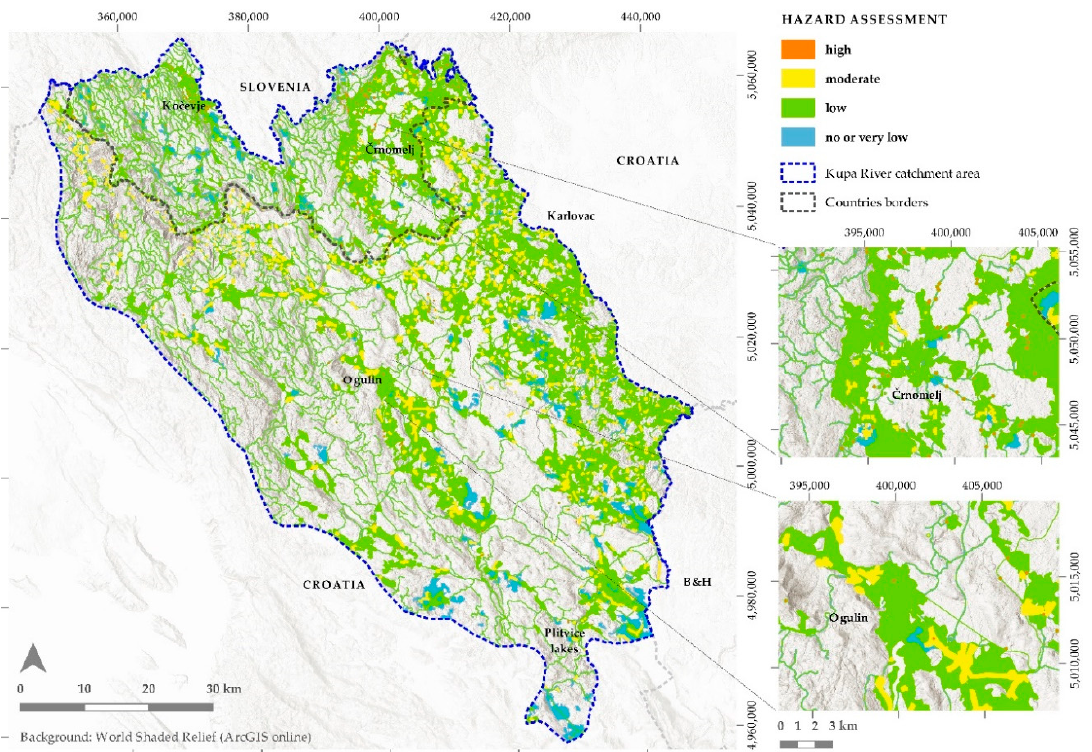
Figure 8. Classified hazard map of the Kupa (Kolpa) River catchment area, showing hazard levels.